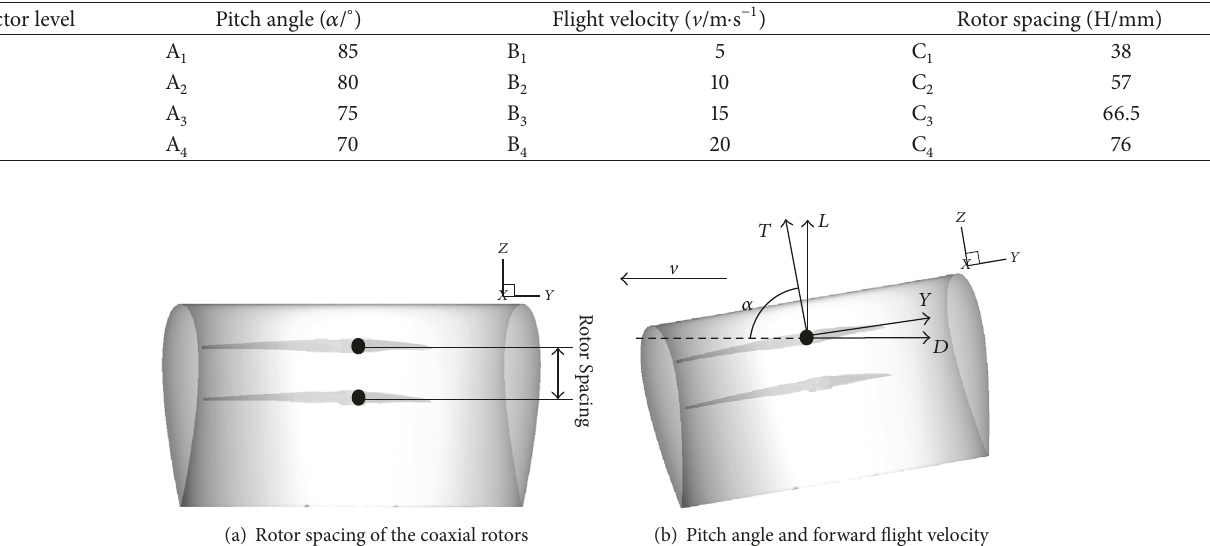
Figure 1: Configuration of VTOL aircraft in forward